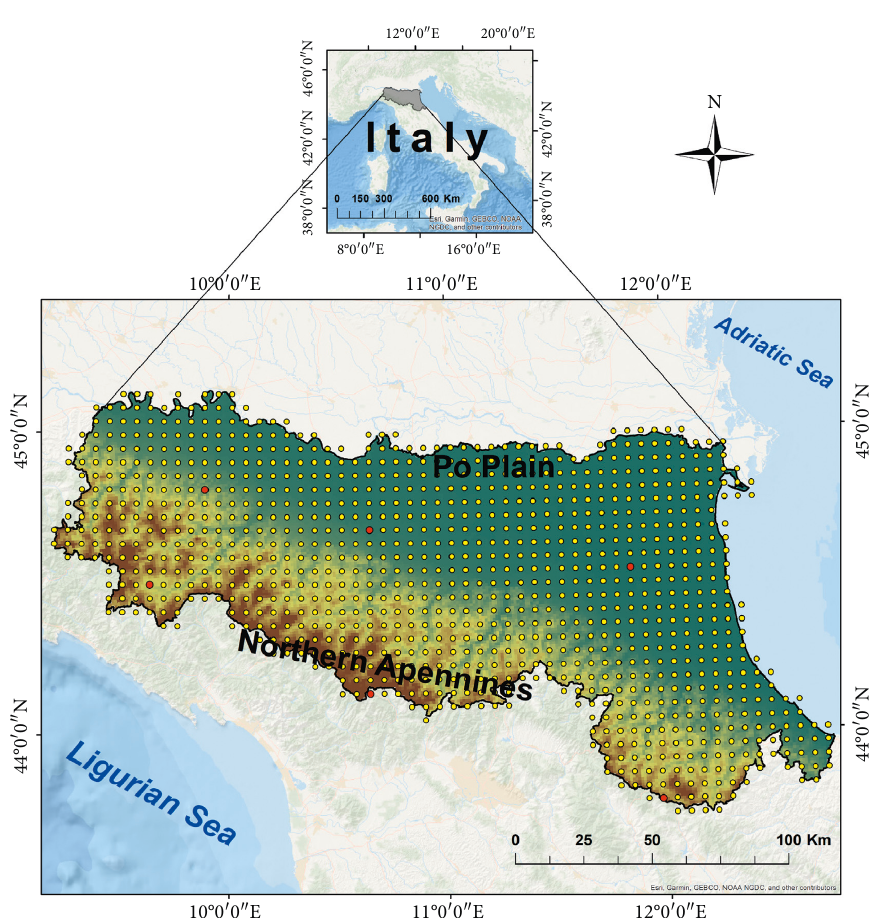
Figure 1: Physical map of the Emilia-Romagna region and distribution weather stations. Red dots represent the stations analysed in detail (e.g., annual trend). Background image source: Esri, Garmin, GEBCO, NOAA NGDC, and other